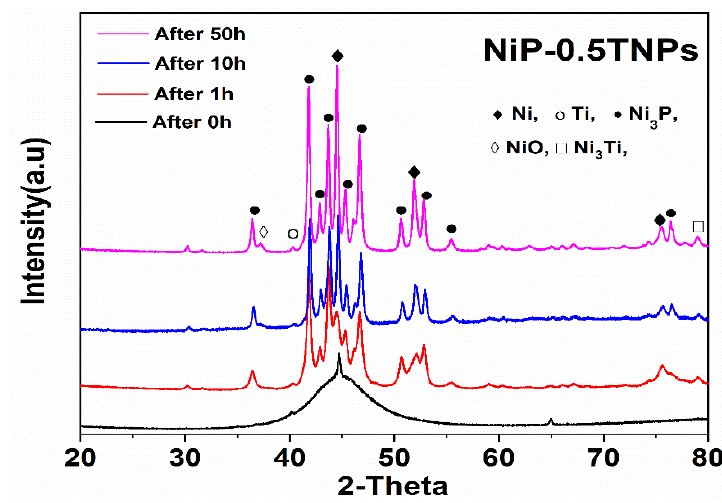
Figure 15. XRD spectra of NiP-0.5TNPs coatings after heat treatment in air at different time intervals.